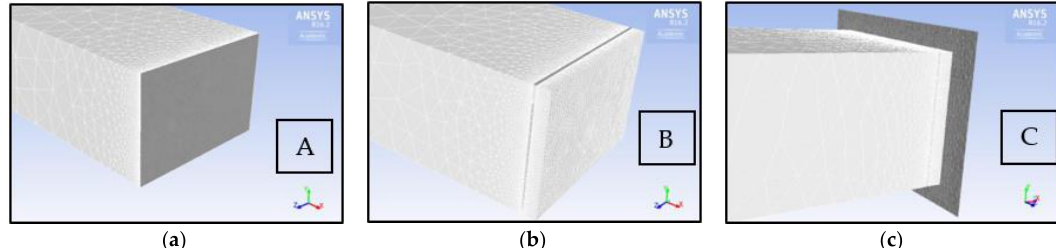
Figure 3. The three control surfaces created for the evaluation of the convective flow in different zones: ( a ) Control surface A positioned in correspondence of the exit of the gases from the furnace; ( b ) Control surface B created in the upper section between the door and the furnace edge; ( c ) Control surface C created outside the door.